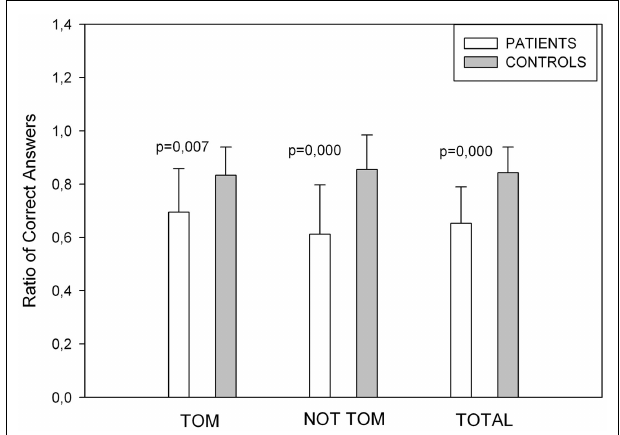
FIGURE 3 | Showing Story Task performance . Control subjects performed better in ToM, non-ToM and in the overall score of the test.